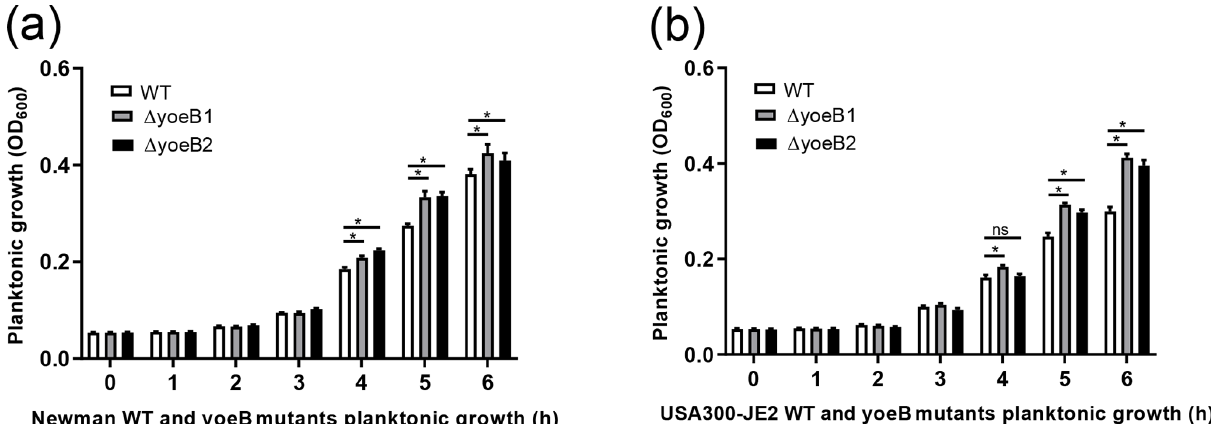
Figure 1. YoeB suppresses S. aureus planktonic growth. (a) Newman and (b) JE2 (ns: not significant, * p < 0 . 05).